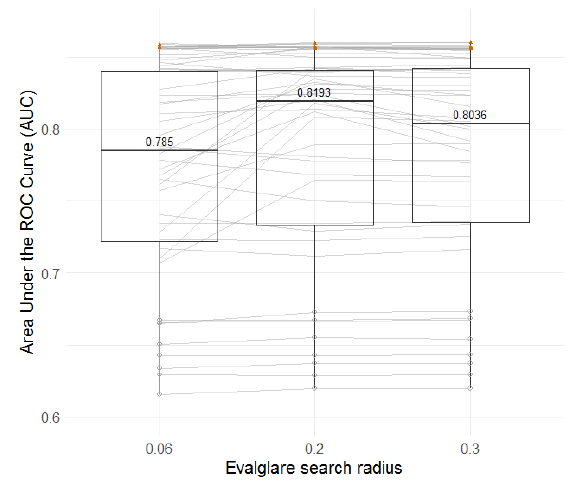
Figure 21. Boxplots of AUC for the three search radius (laboratory study).